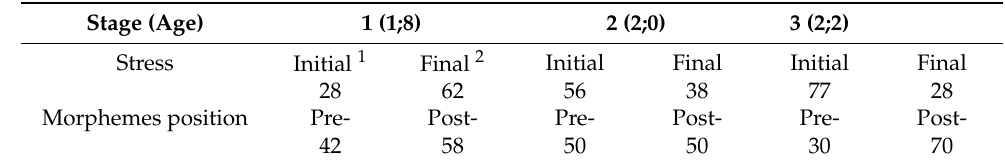
Table 1. Proportion of initial and final stress pattern (% of the total number of patterns) and of pre- and postposed morphemes in the Swedish utterances of Jean (Swedish dominant).